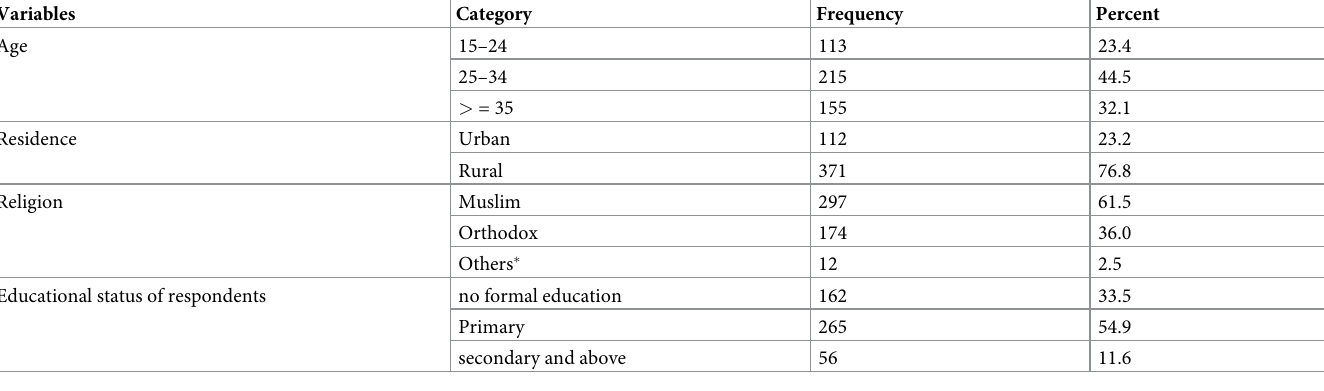
Table 2. Socio-demographic characteristics of reproductive age women in South Gondar, Ethiopia, 2017 (n = 483).